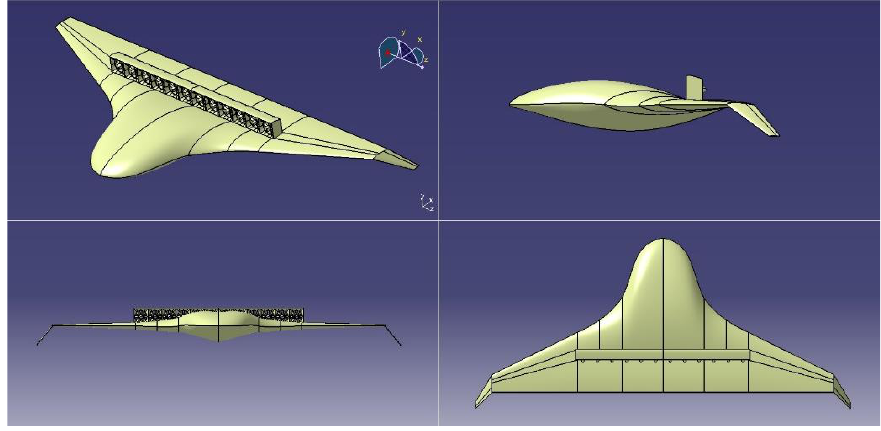
Figure 1 . Sketch of the DEP-based BWB UAV conceptual configuration. Figure 1. Sketch of the DEP-based BWB UAV conceptual Table 1 . Reference dimensions, flight conditions, and cruise targets of the present DEP-based BWB UAV.